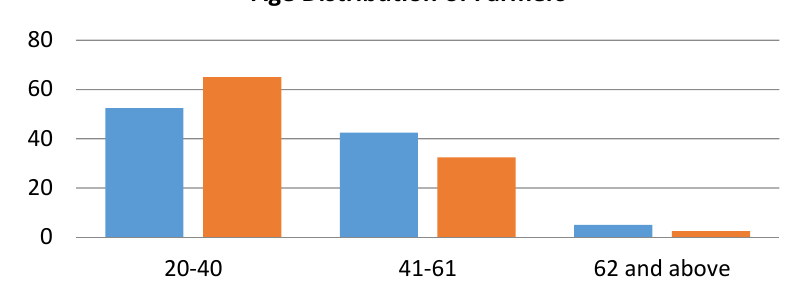
Figure 2. Age distribution of farmers.